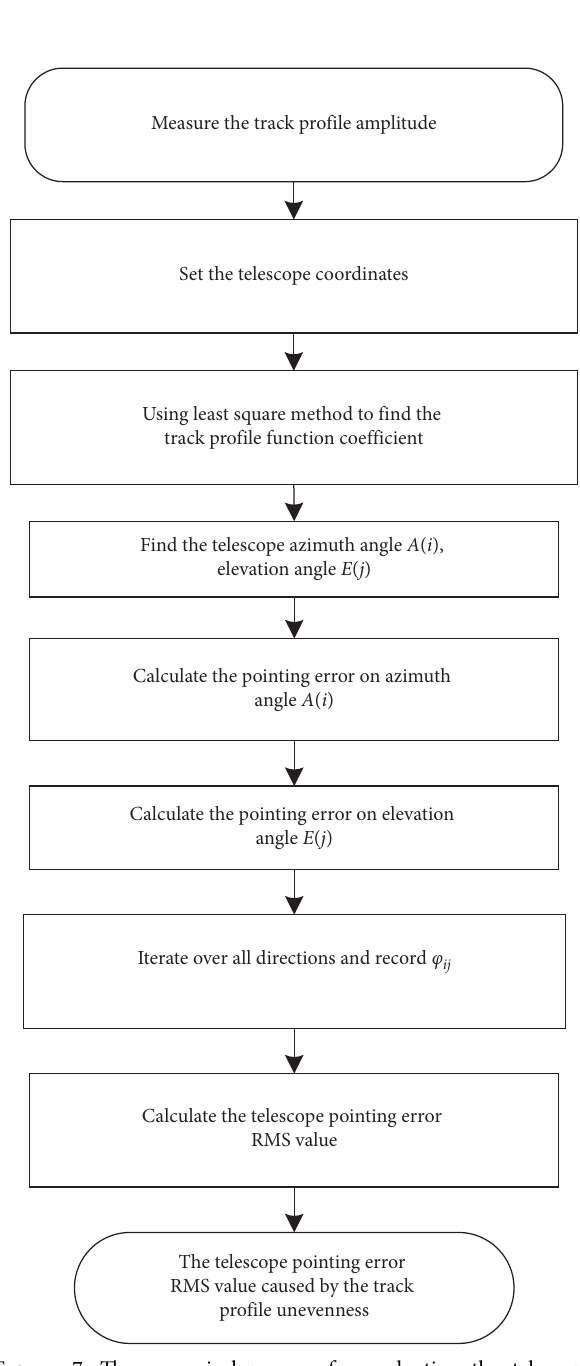
Figure 7: The numerical process for evaluating the telescope pointing